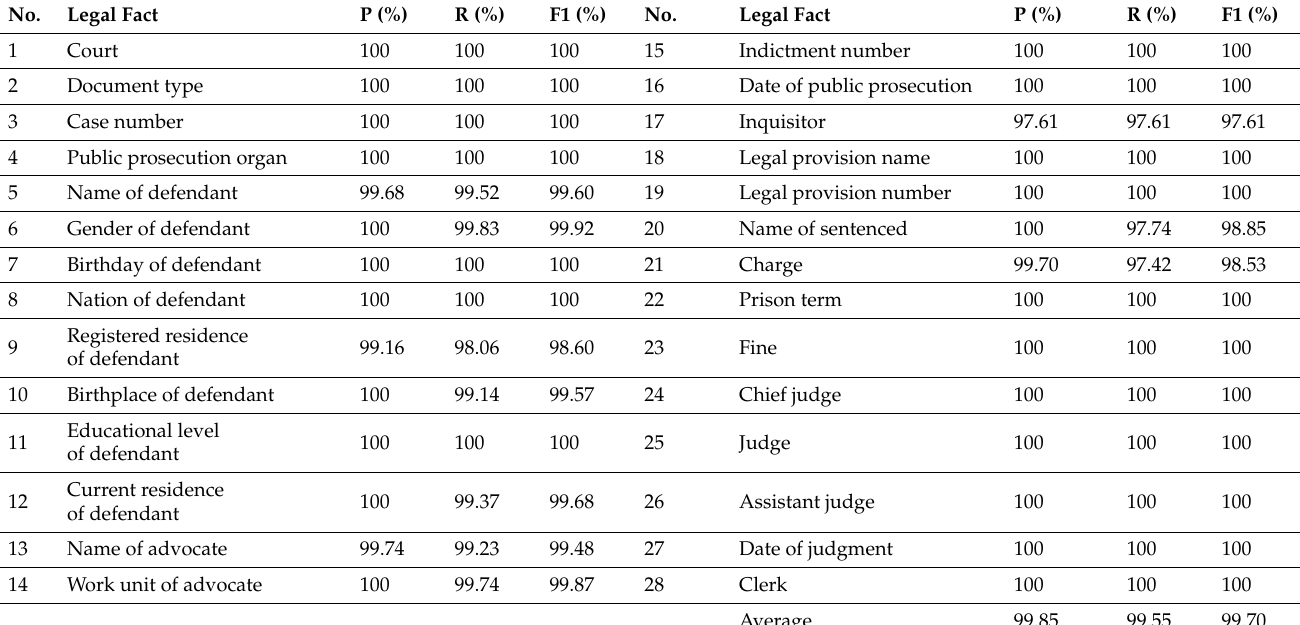
Table 5. Results of the rule-based extractor on the judicial dataset.